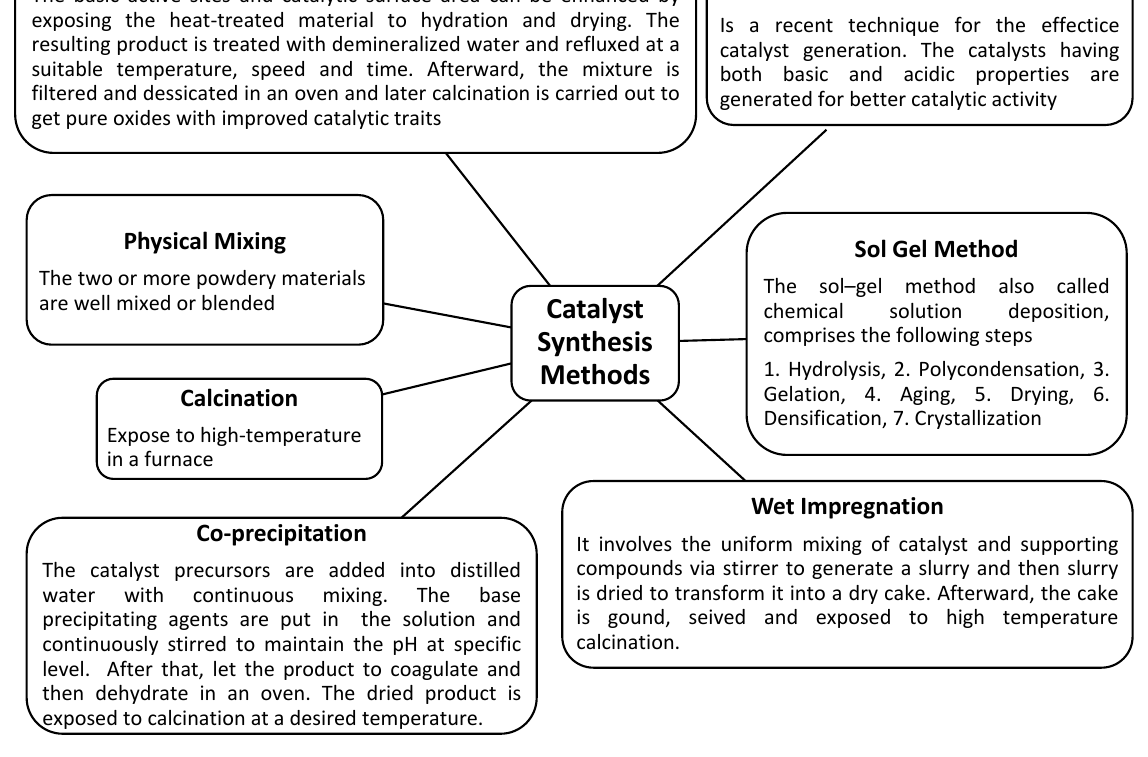
Figure 2. Generic synthesis method for transforming agricultural wastes into a solid catalysts.